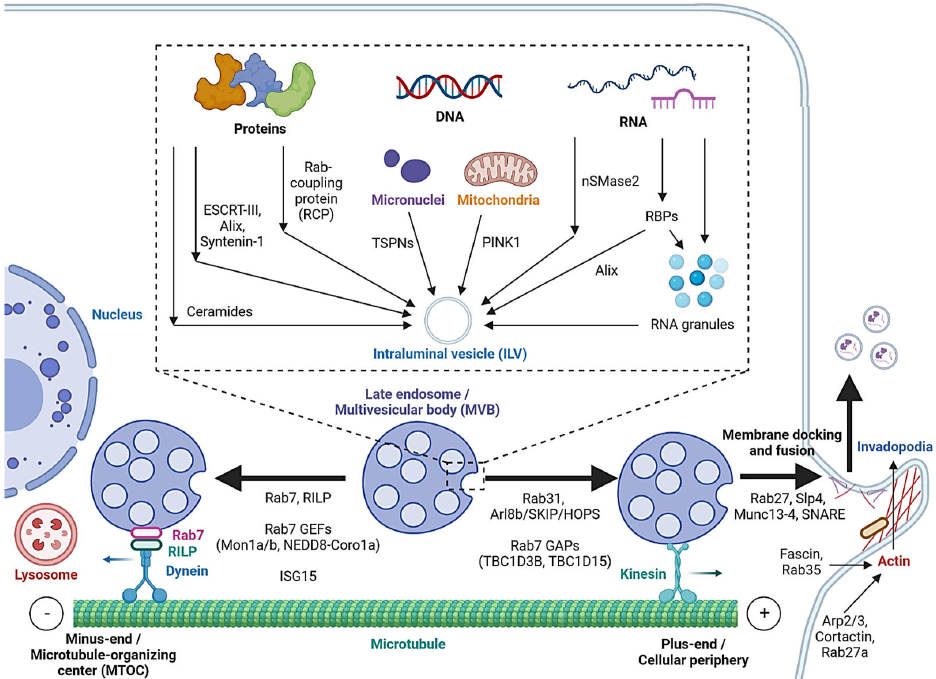
Figure 2. Cargo sorting mechanisms and the regulation of MVB tra ffi cking and fusion with the cell membrane. Proteins are sorted into ILVs by associating with ESCRT-dependent and ESCRT-independent machinery and Rab coupling protein (RCP). Tetraspanins and PINK1 are involved in the loading of genomic DNA (gDNA) and mitochondrial DNA (mtDNA), respectively. RNA loading is regulated by nSMase2 and RNA-binding proteins (RBPs). Alix binds to the RBP Ago2 and promotes miRNA loading. RNA granules formed by liquid–liquid phase separation (LLPS) contain RNAs and RBPs and promote miRNA, lncRNA and circRNA loading. MVBs can be fated towards lysosomal degradation by translocation towards the microtubule minus-end or the perinuclear region. Alternatively, they are fated towards secretion by translocation towards the plus-end or the cellular periphery. Actin polymerization at invadopodia stabilizes MVB docking sites. MVB fusion is mediated by SNARE proteins, which are regulated by Rab27 and its e ff ectors, Slp4 and Munc13-4.